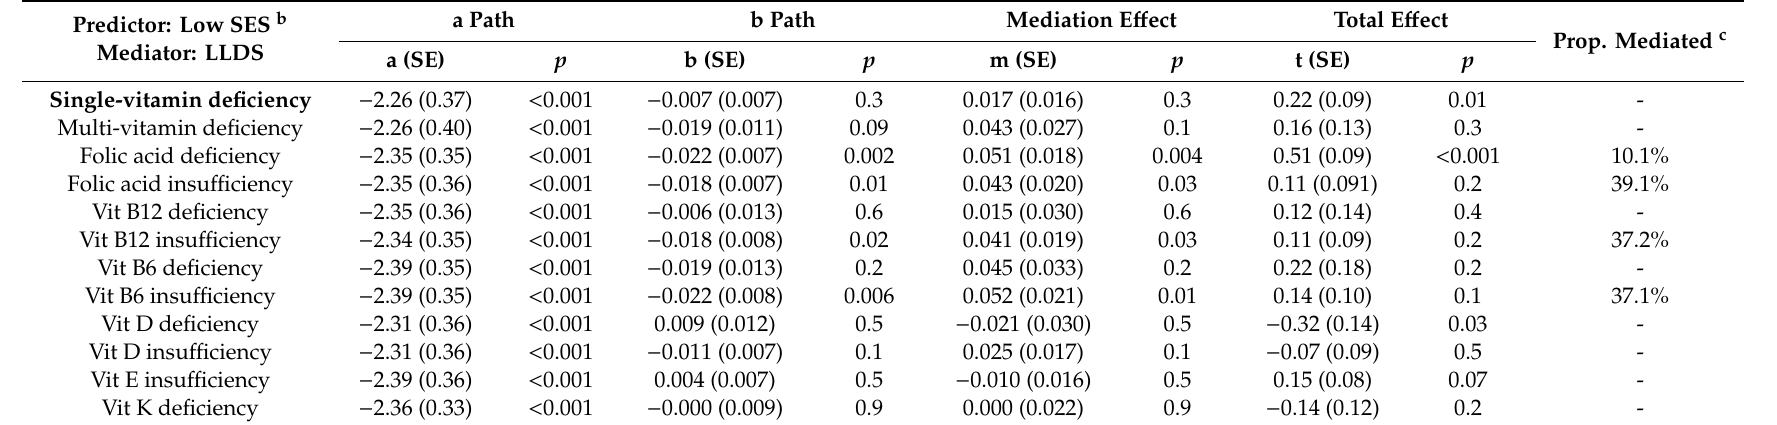
Table 4. Mediating the role of the LLDS on the associations between SES and vitamin deficiencies and insu ffi ciencies